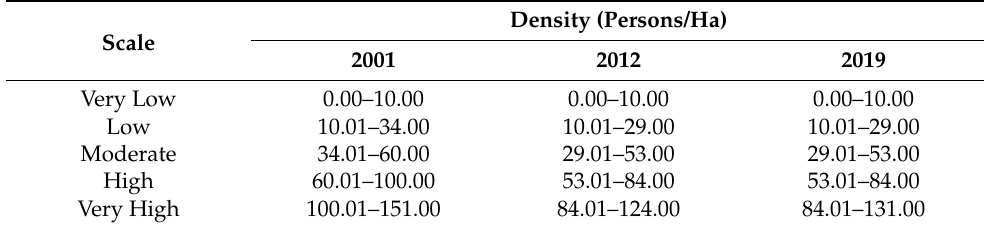
Table 7. The range of population density in Batticaloa Municipality.